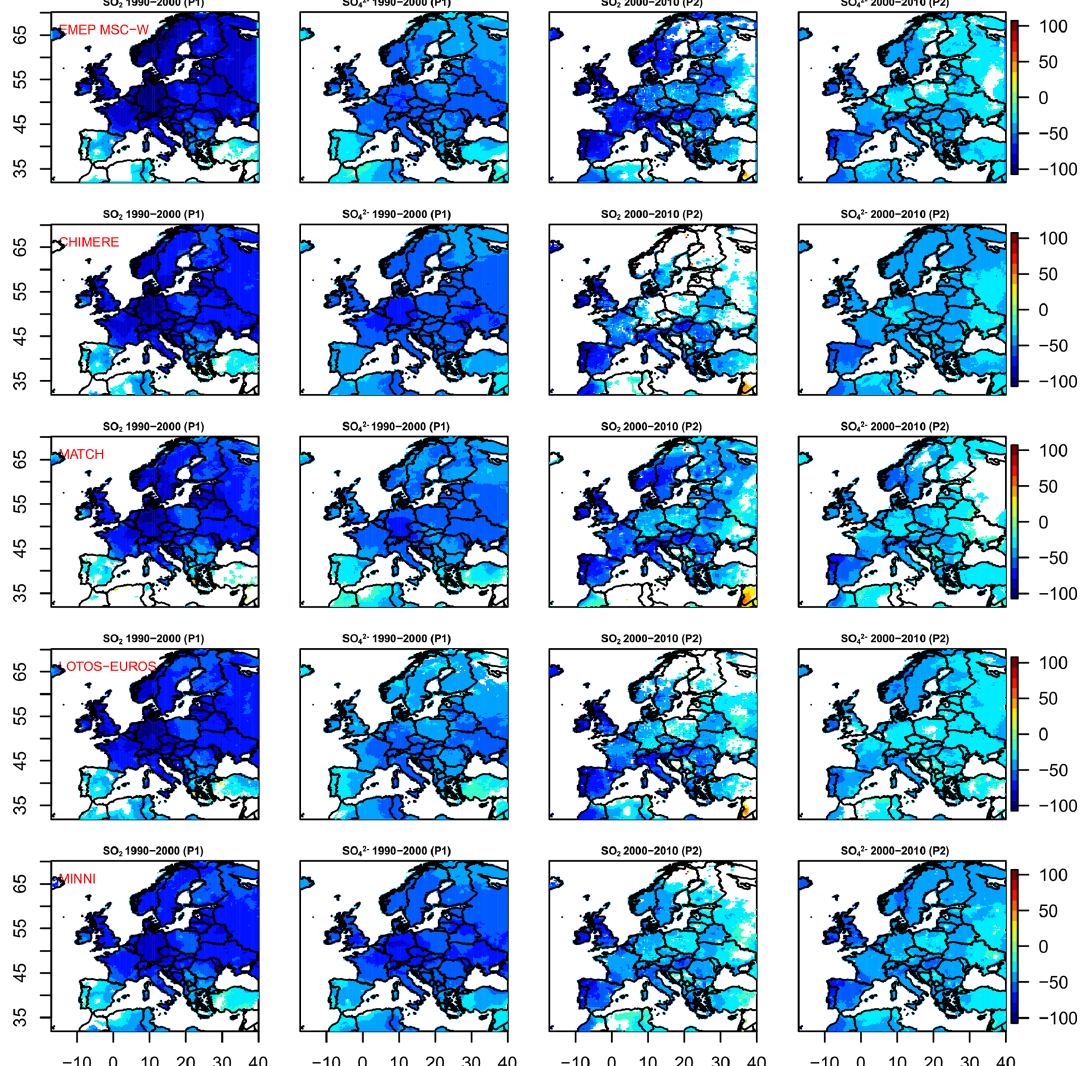
Figure 12. Modeled SO 2 and SO 2 − relative trends over land for the P1 (1990–2000, first and second columns) and P2 (2000–2010, third and 4 fourth columns) periods as predicted by all the models (rows; from top to bottom: EMEP MSC-W, CHIMERE, MATCH, LOTOS-EUROS, MINNI). White areas indicate non-significant trends. The scale was saturated at 100% to facilitate the comprehension of the panels.